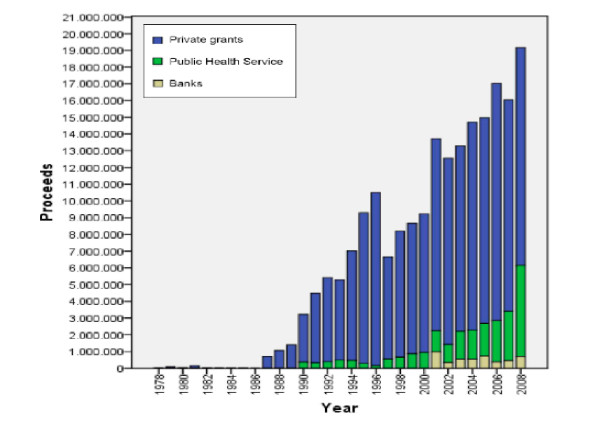
Until 1998, ANT was financed solely with private grants. From 1990 to 2000, contributions from bank foundations were added and in 2001, the public health system allocated funds. Private grants (blue square), Public Health Service (green square), Banks (yellow square).